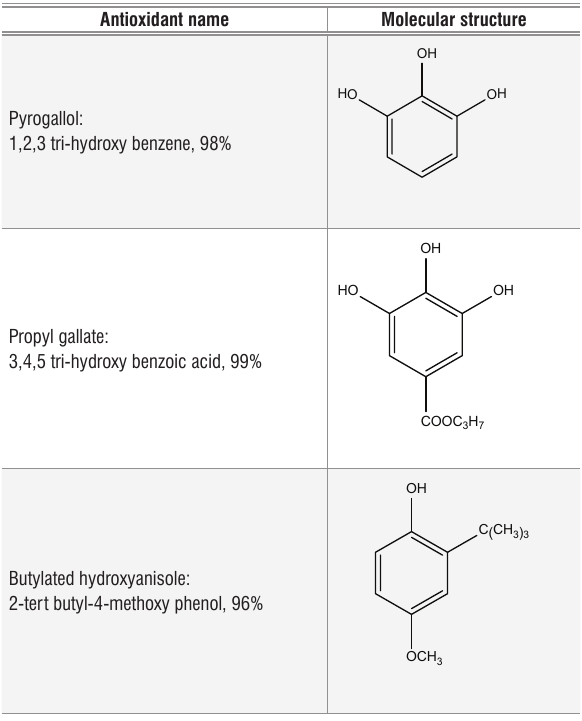
Table 2: Synthetic antioxidants Antioxidant name Molecular